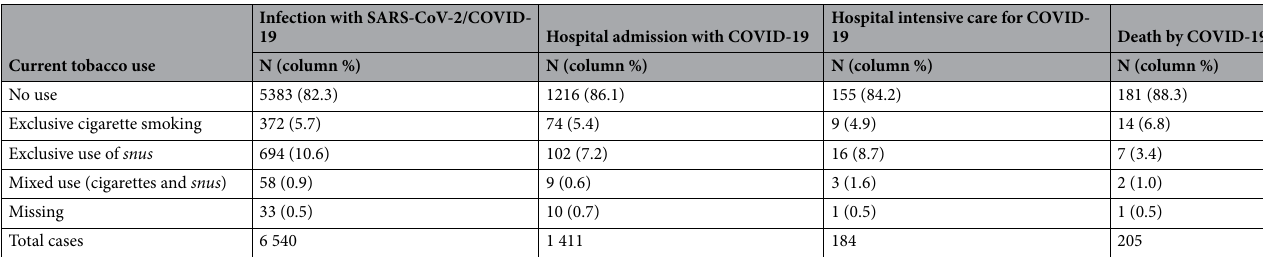
Table 2. COVID-19 incident outcomes February 25–October 22, 2020 among clients of the public dental care in Stockholm Region, by categories of tobacco use.